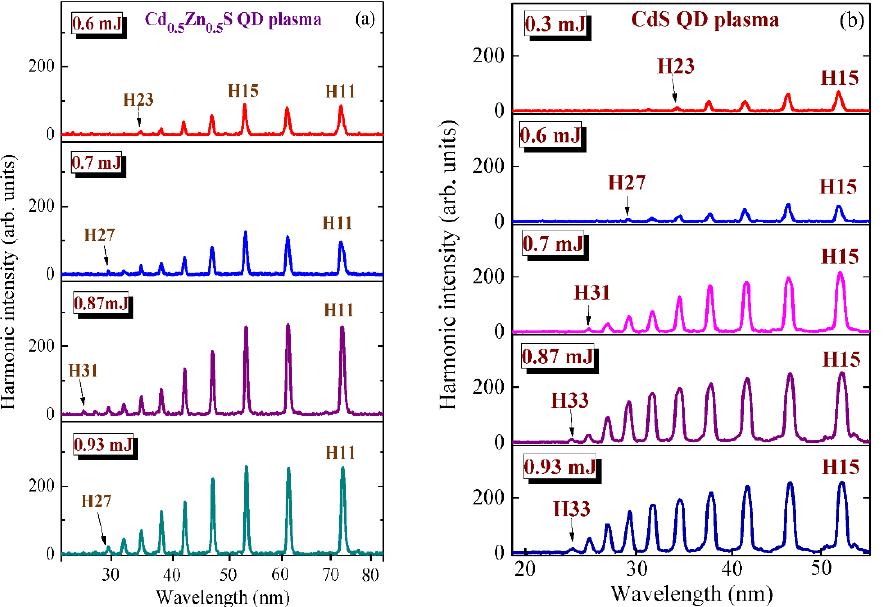
Figure 15. ( a ) HHG in Cd 0.5 Zn 0.5 S QD LIP. ( b ) HHG in CdS QD LIP. Reprinted with permission from Ref. [49], 2019, American Institute of Physics. Ref. [49], 2019, American Institute of Physics.